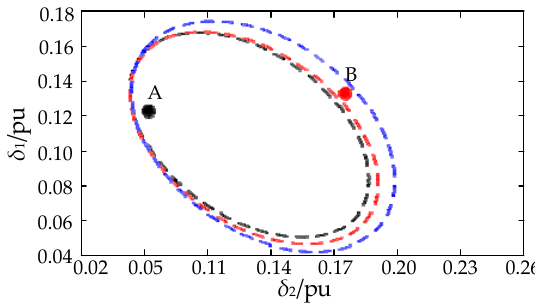
Figure 7. Projective figures of stability region boundary of test system 2 in δ 1 – δ 2 phase plane.